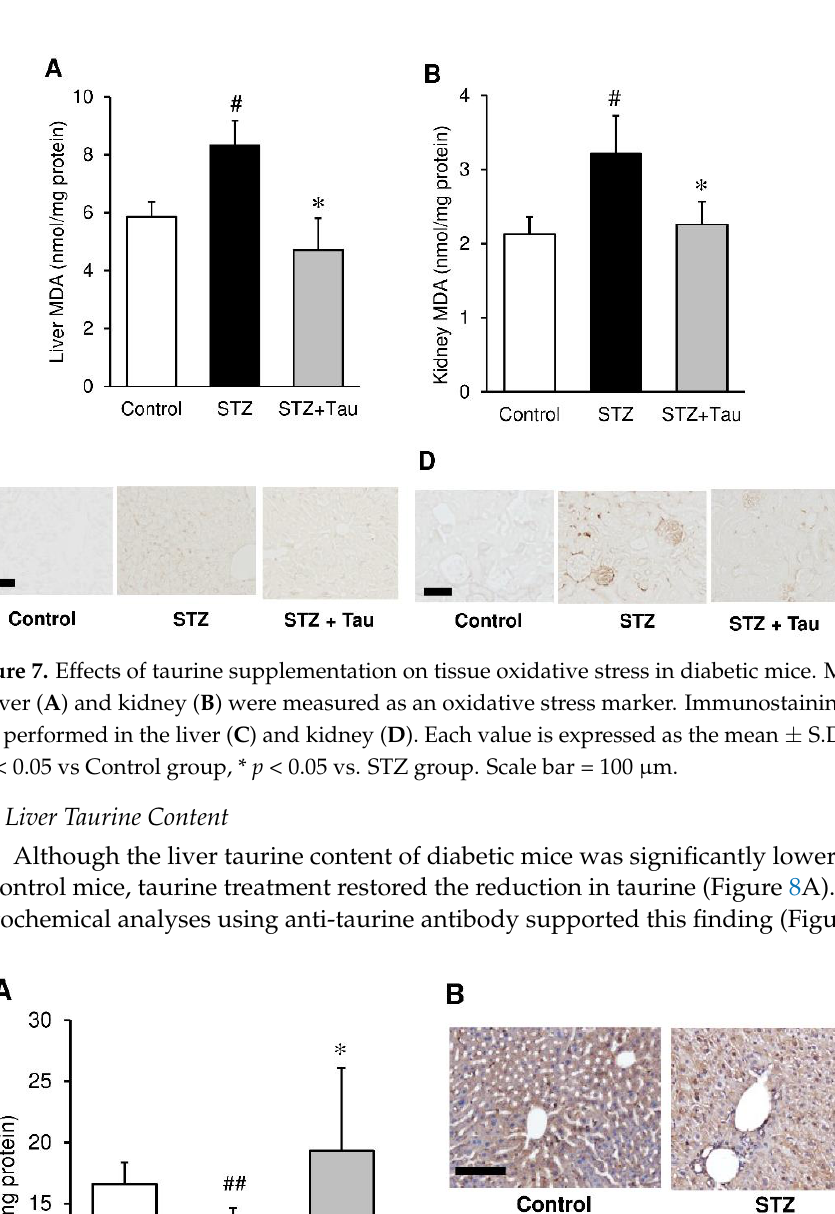
Figure 9. Effects of taurine supplementation on the insulin and taurine levels in pancreas of diabetic mice. Double immunofluorescence staining for taurine and insulin was performed in the pancreas ( A ). The areas of insulin-positive cells were measured, and the percentage in the islets was calcu- lated ( B ). Each value is expressed as the mean ± S.D. ( n = 24), ## p < 0.01 vs Control group, * p < 0.05 vs STZ group. 3. Discussion The present results showed that taurine treatment ameliorated hyperglycemia and insulin resistance in STZ-induced diabetic mice. The hypoglycemic effect of taurine was mild, and in some weeks, there were no significant differences in blood glucose compared